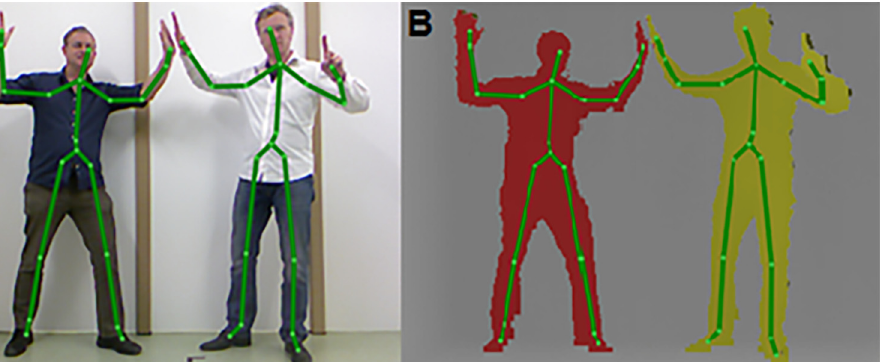
Fig 1. Body points derived with the human-pose estimation software of Kinect v1. (A) RGB image and (B) depth image with the corresponding body points derived with the human-pose estimation software of Kinect